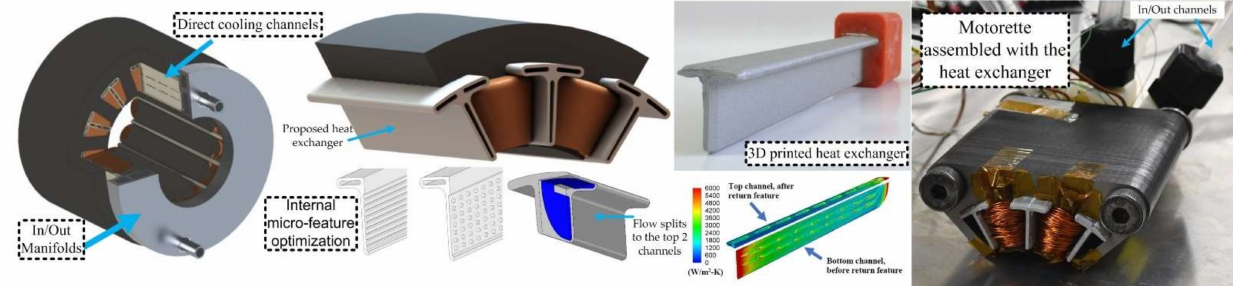
Figure 19. Ceramic 3D-printed direct-winding heat exchangers for improved thermal perfor- mance [50–52].